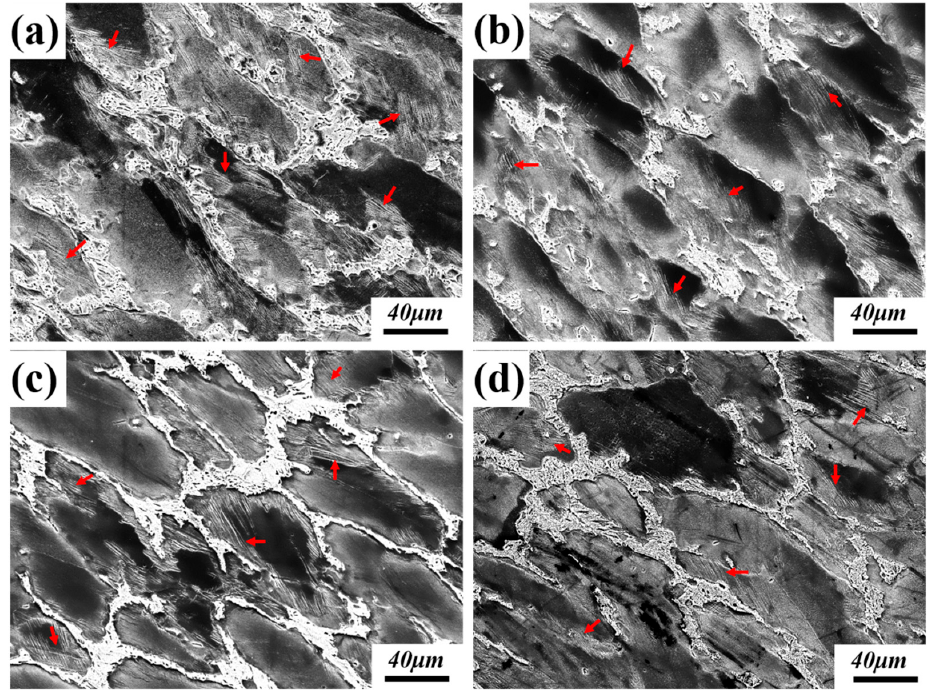
Figure 8. ( a ) Enlarged image of the white boxed region in Figure 7c, ( b ) high-resolution transmission electron microscopy (HRTEM) image of the white boxed region in Figure 8a region B (inset is filtered Fourier transformation (FFT) mode), ( c ) Figure 8b white boxed area of region B corresponding (111)M and (002)T inverse filtered Fourier transformation (IFFT) images, ( d ) Figure 8b white boxed area of region c corresponding (111)M and (002)T IFFT images.